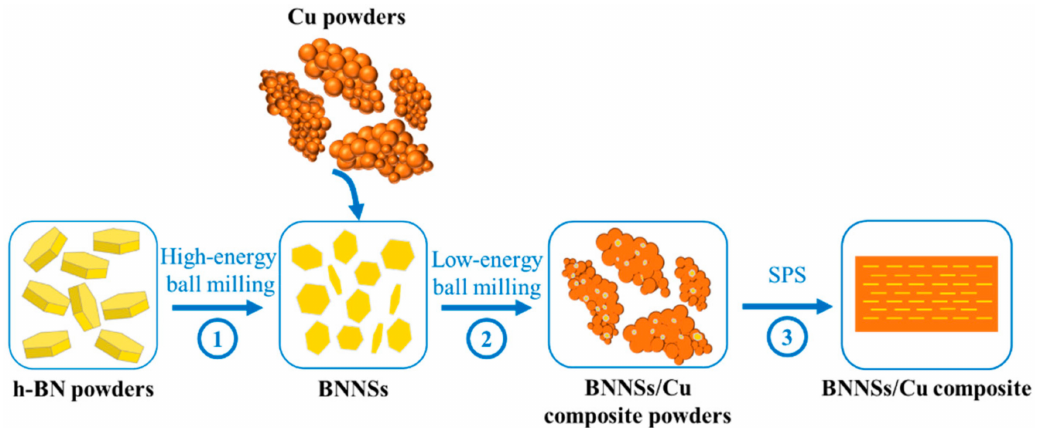
Figure 1. Schematic of fabrication process of BNNSs/Cu